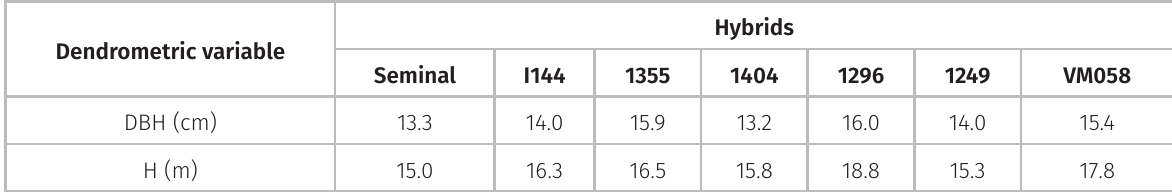
Table II. Dendrometric characteristics of seven 4-year-old Eucalyptus hybrids in Vitória da Conquista – BA.